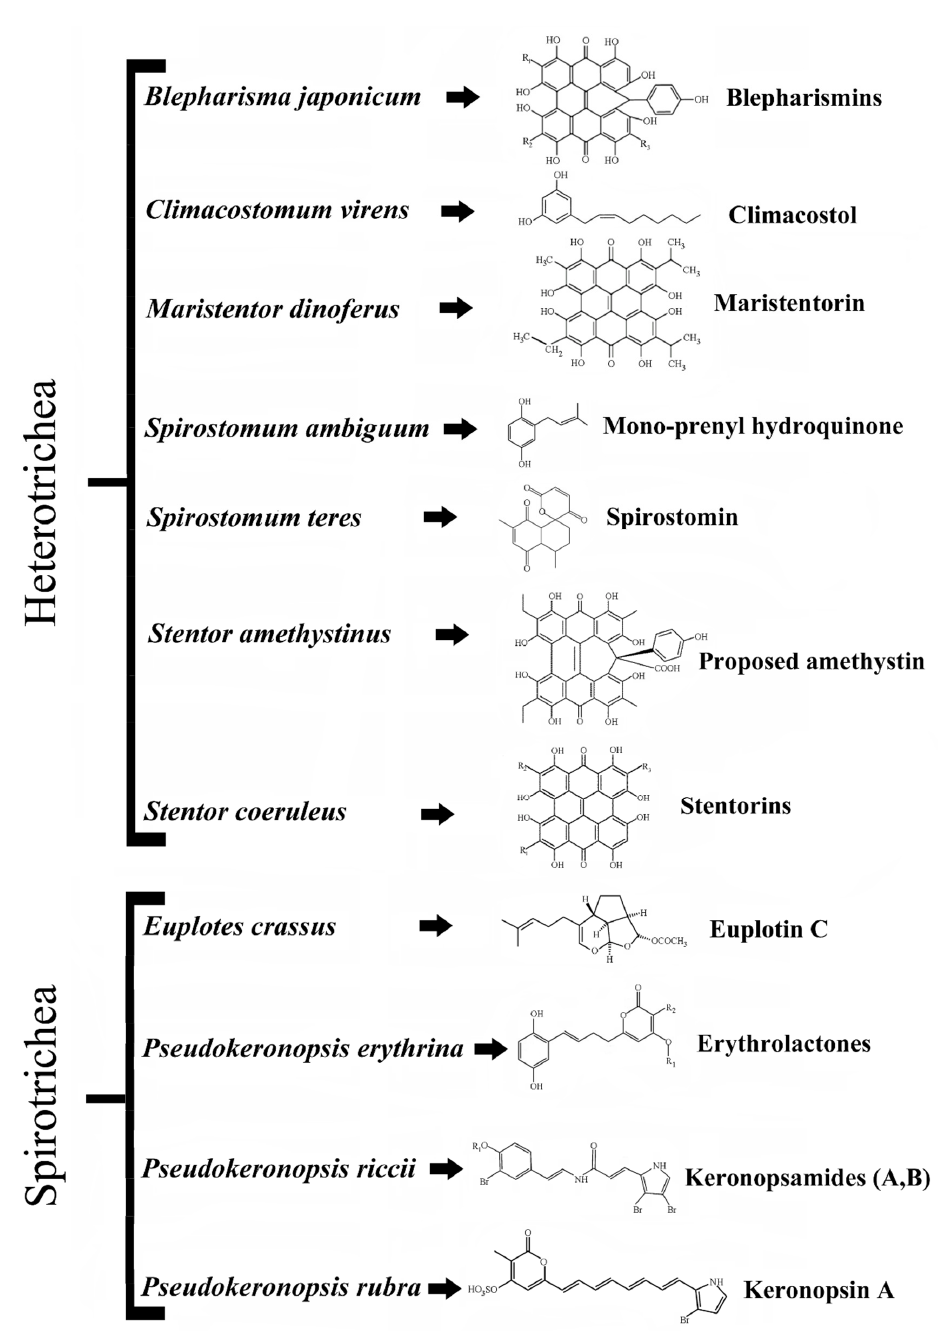
Figure 1. Relevant secondary metabolites with biological activities produced by ciliated protists. Blepharismins: BP-A (R 1 = C 2 H 5 ; R 2 = C 2 H 5 ; R 3 = H); BP-B (R 1 = C 2 H 5 ; R 2 = i -C 3 H 5 ; R 3 = H); BP-C (R 1 = R 2 = i -C 3 H 5 ; R 3 = H); BP-D (R 1 = C 2 H 5 ; R 2 = i -C 3 H 5 ; R 3 = CH 3 ); BP-E (R 1 = R 2 = i -C 3 H 5 ; R 3 = CH 3 ). Stentorins: S-C (R 1 = i -C 3 H 5 ; R 2 = i -C 3 H 5 ; R 3 = H). Erythrolactones: E-1 (R 1 = SO 3 ; R 2 = C 6 H 13 ); E-2 (R 1 = SO 3 ; R 2 = C 7 H 15 ); E-3 (R 1 = SO 3 ; R 2 = C 8 H 17 ); E-4 (R 1 = H; R 2 = C 6 H 13 ); E-5 (R 1 = H; R 2 = C 7 H 15 ); E-6 (R 1 = H; R 2 = C 8 H 17 ). Redrafted from [3] and reproduced under